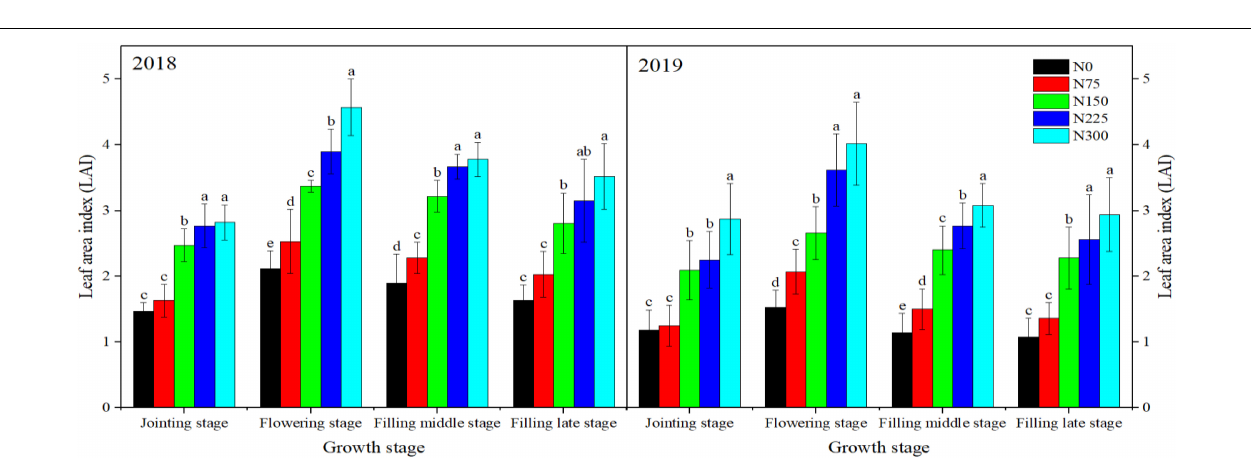
FIGURE 2 | Rainfall and average temperature during the winter wheat growing seasons in 2018 and 2019 in Yangling, China.